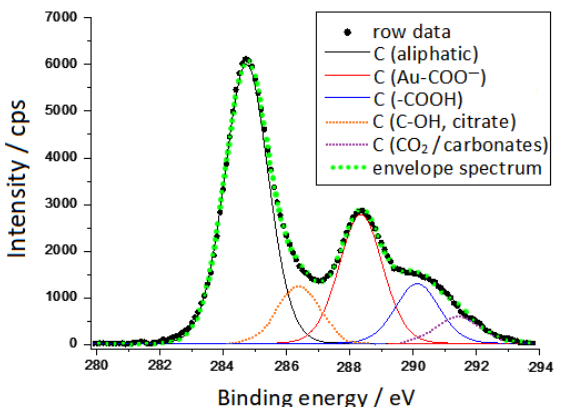
Figure 1. X-ray photoelectron spectroscopy (XPS) spectrum of deposited Au nanoparticles in the carbon 1s spectral region.